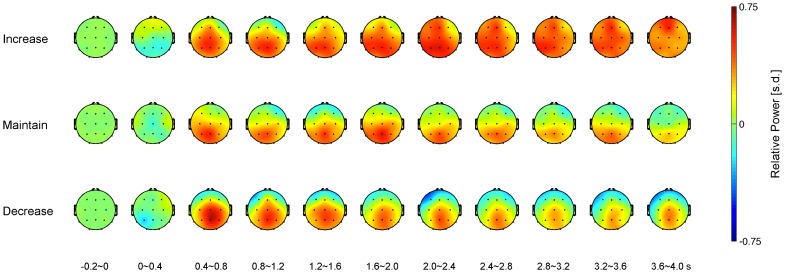
Time-varying topographic maps of gamma power in three different cognitive reappraisal conditions.Gamma power in each of the 13 EEG channels (see small black dots) was subtracted from the mean of the baseline power and divided into the standard deviation of the baseline power, resulting in the relative power. Bottom labels represent the time windows based on visual stimulus onset (increase, top; maintain, mid; decrease, bottom).